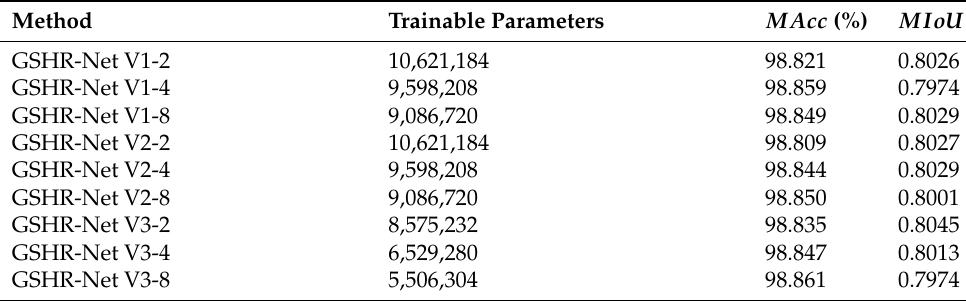
Table 1. Performance comparison between variants of